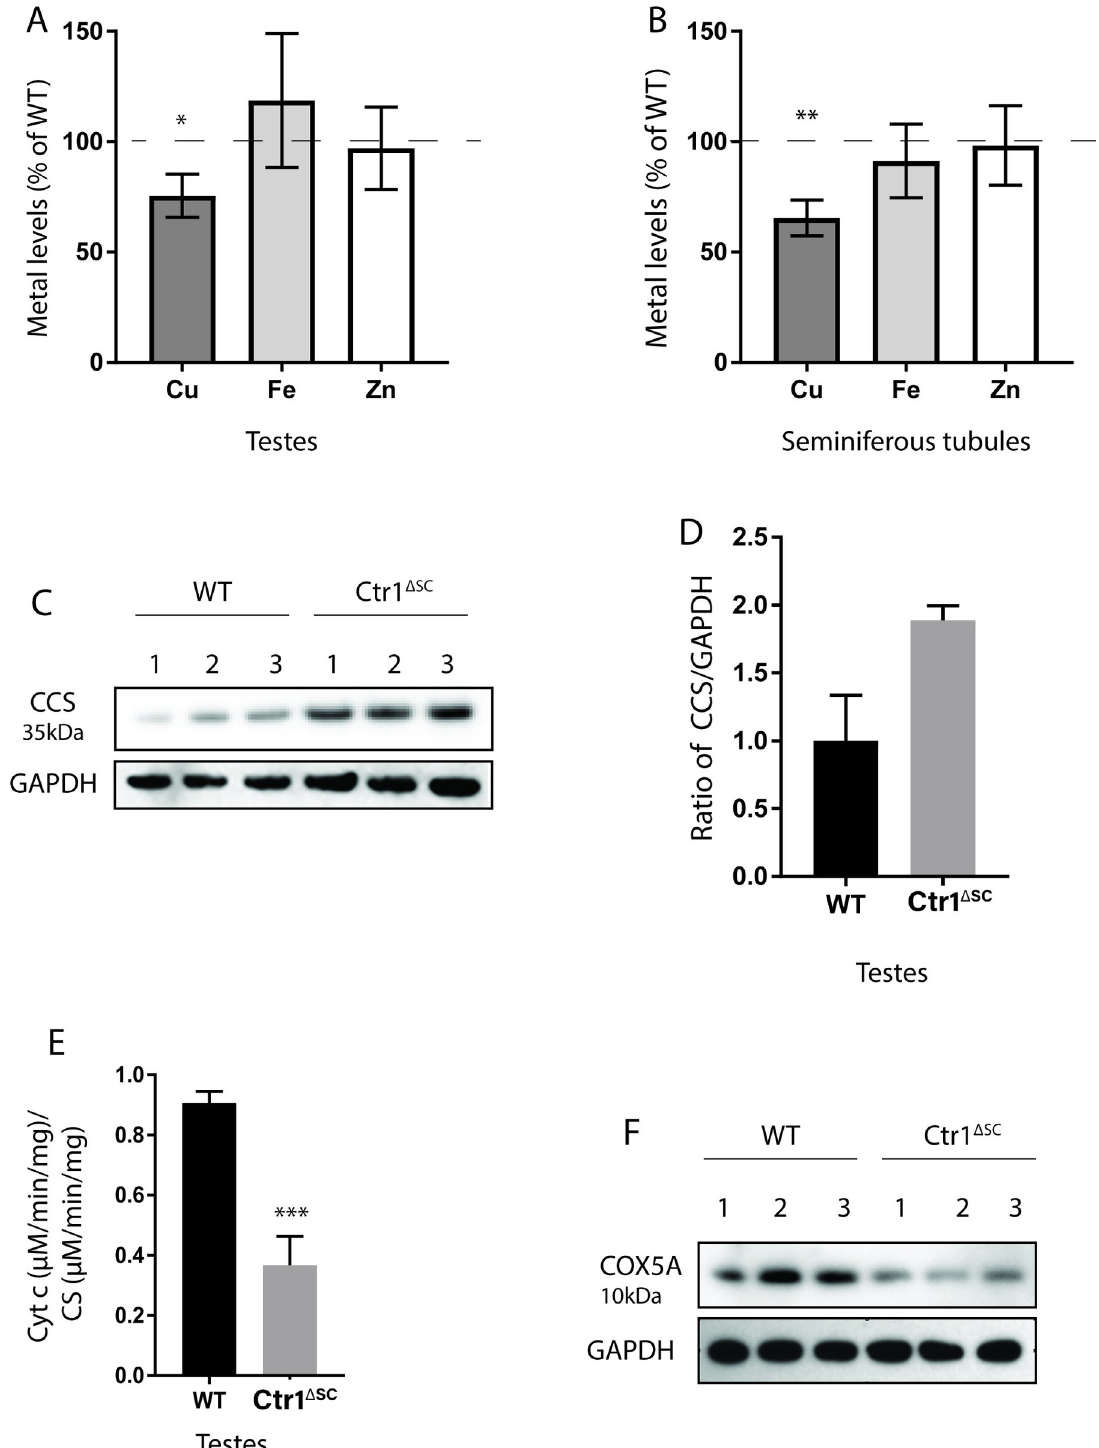
Fig 5. Ctr1 Δ SC mice exhibit testicular copper deficiency. ( A) Relative Cu, Fe and Zn levels in Ctr1 Δ SC testis and in (B) Ctr1 Δ SC seminiferous tubules compared to WT testis. Data represent percent concentration ( μ g/g dry tissue weight) of Ctr1 Δ SC tissues compared to WT tissues (average ± SD). Dashed line represents 100% of each metal in WT tissues. For each genotype N = 4–5, � P < 0.05, �� p < 0.005. (C) Immunoblot analysis on CCS and GAPDH is shown as loading control. Three animals were randomly selected and analyzed from each WT and Ctr1 Δ SC mice. Each number above represents an animal from each genotype. (D) Quantified protein expression of